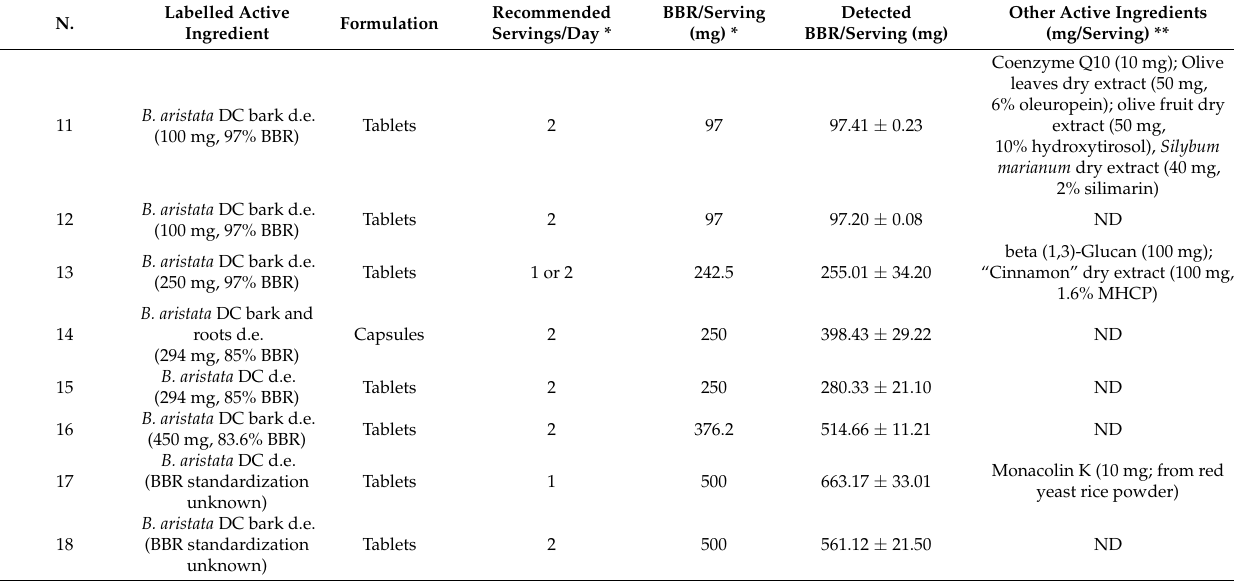
Table 3. Amounts of active ingredients, pharmaceutical forms and labelled information of food supplements containing berberine as the main active ingredient. Detected berberine amounts are reported as mean mg/serving ± SD.